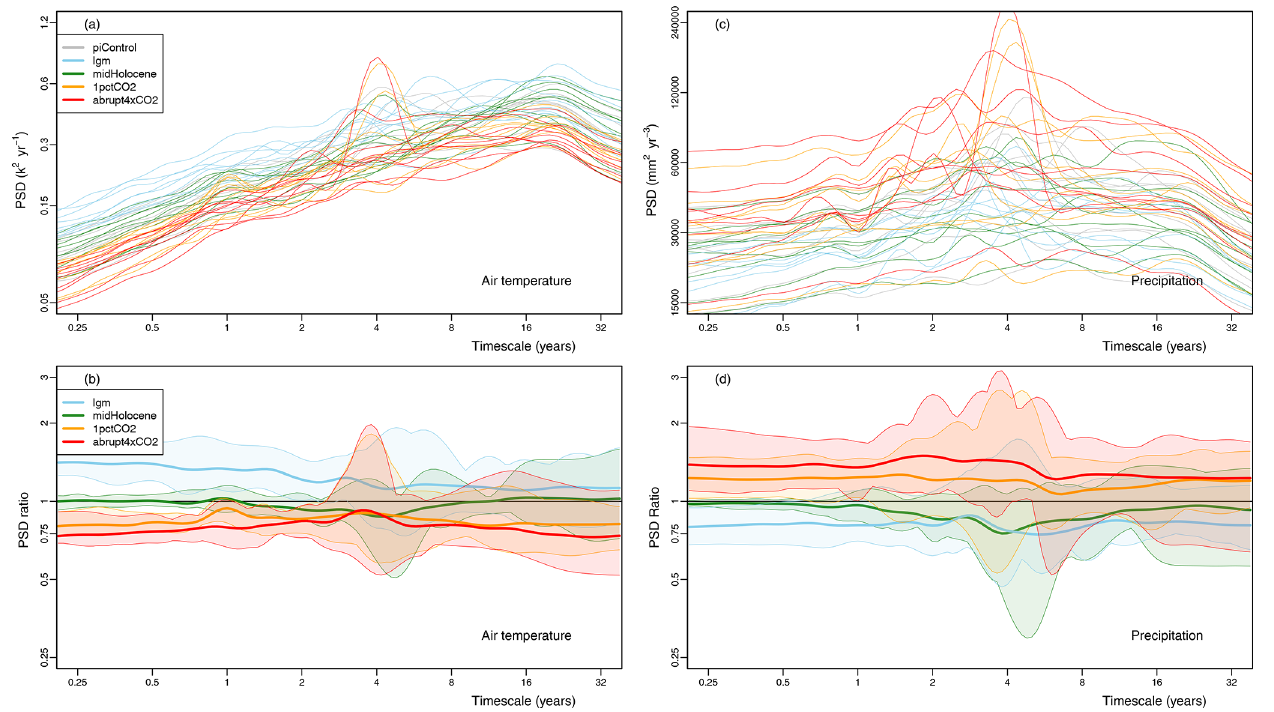
Figure 6. Changes in the global mean of the power spectra between the experiments. For temperature (a) , variance across all timescales and for most models is highest in the lgm experiment and decreases for the warmer experiments. This is the opposite for precipitation (c) , which sees moderate increases in precipitation variability with warming. For each model, we took the ratio of the global mean spectra of each experiment to the piControl for both temperature (b) and precipitation (d) , thus showing the timescale dependency of the local variance change. Shaded confidence intervals are based on the entire range of the model